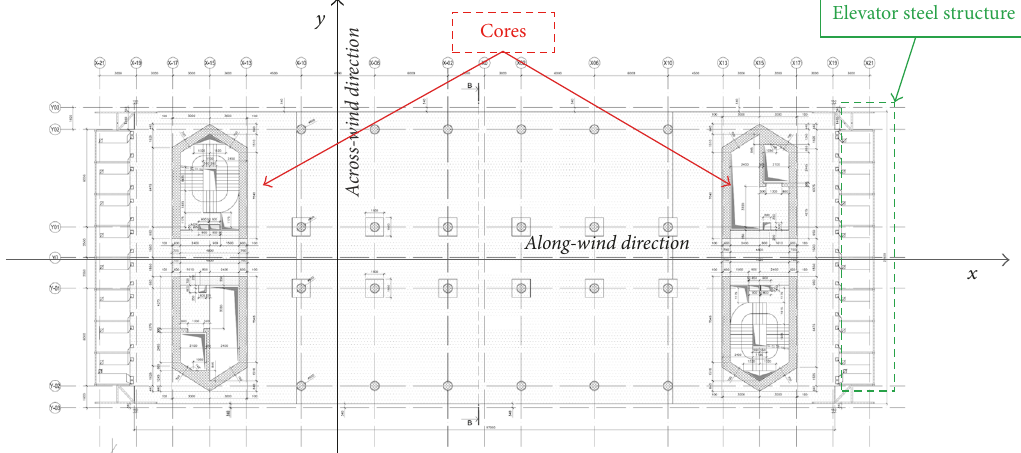
Figure 1: Typical floor plan.